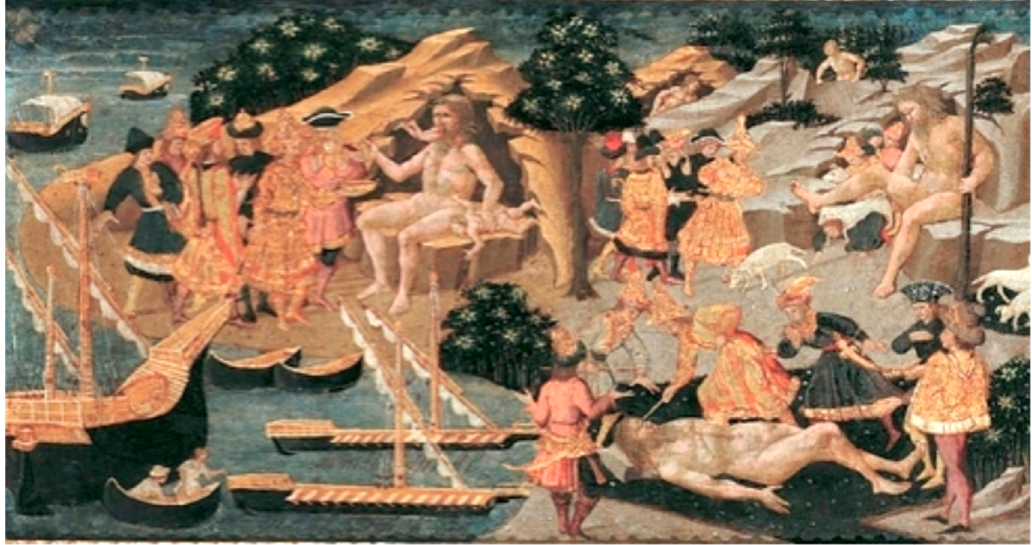
Figure 4. Apollonio di Giovanni, The Adventures of Odysseus , detail Figure 1. Humanities 2018 , 7 , x FOR PEER REVIEW